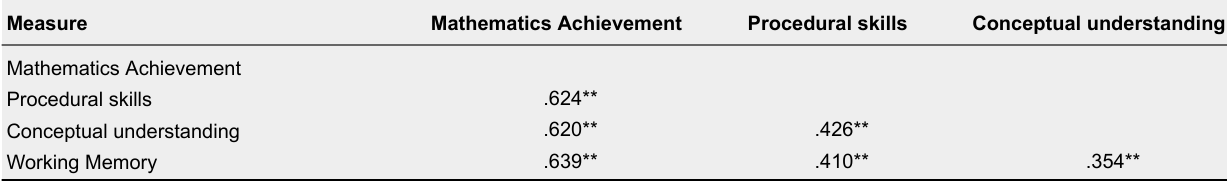
Correlations Among Measures of Mathematics Achievement, Procedural Skills, Conceptual Understanding and Working Memory Measure